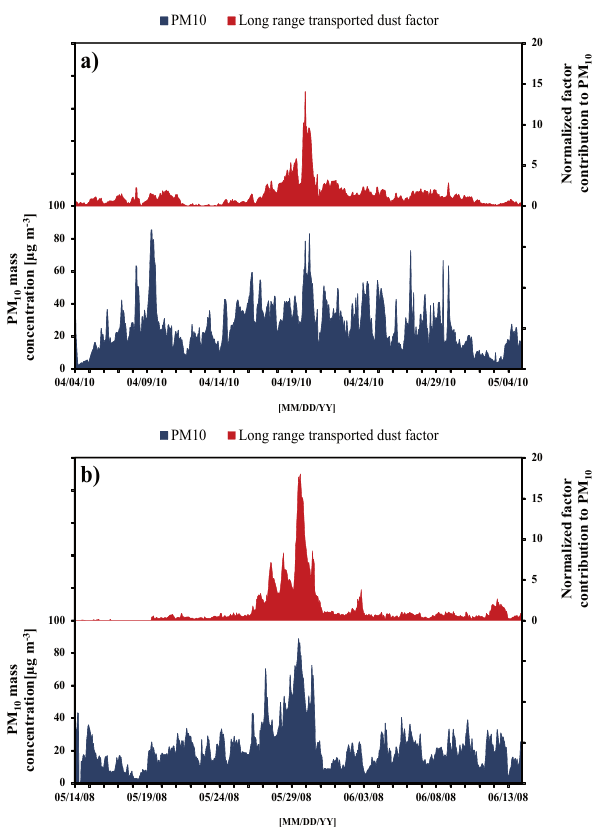
Fig. 5. Time series section of hourly average PM 10 mass concen- tration and normalized PM 10 contribution of long range transported dust factor during (a) Eyjafjallaj¨okull ash plume impact 2010 and (b) Saharan dust event 2008 at the University of Applied Sciences in Augsburg,